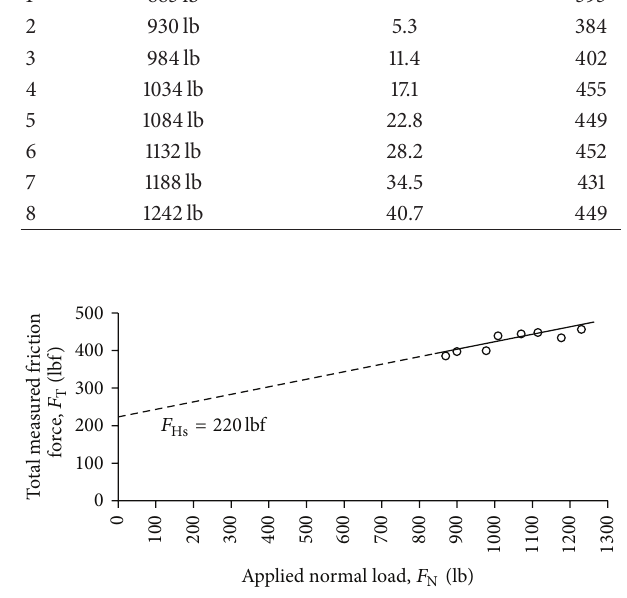
Figure 13: Wet Belcher Road test